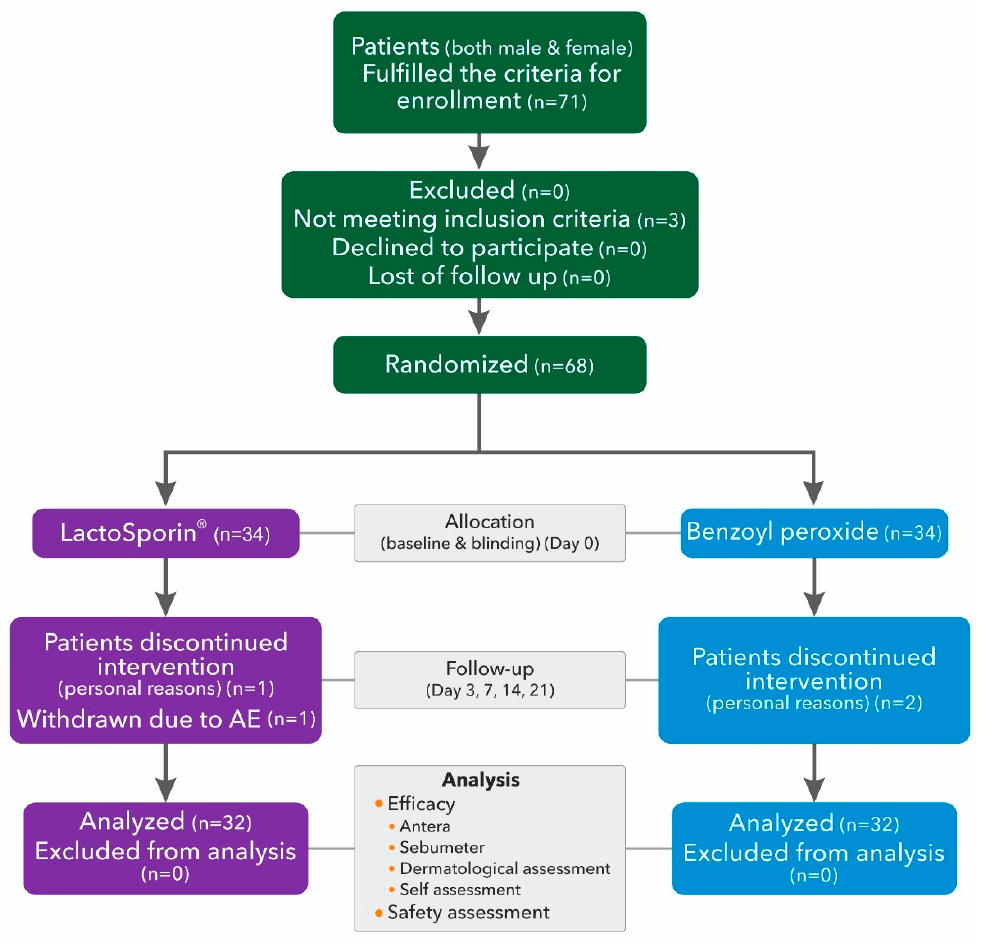
Figure 2. Consort study flow diagram. AE: adverse events.